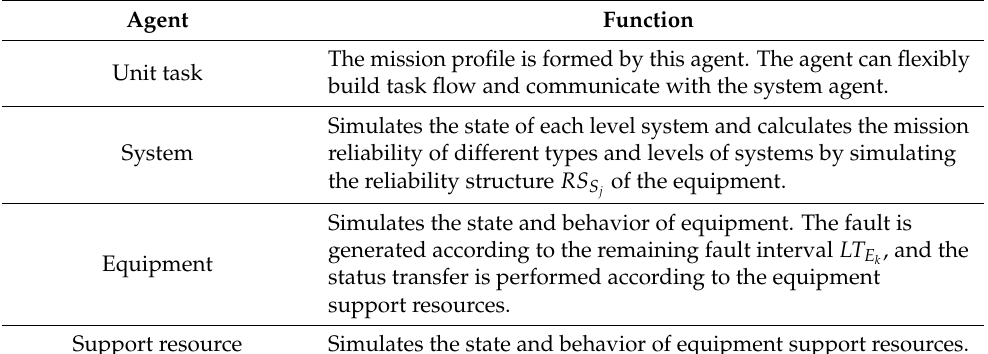
Table 1. Functional design of the agents. Agent Function The mission profile is formed by this agent. The agent can flexibly Unit task